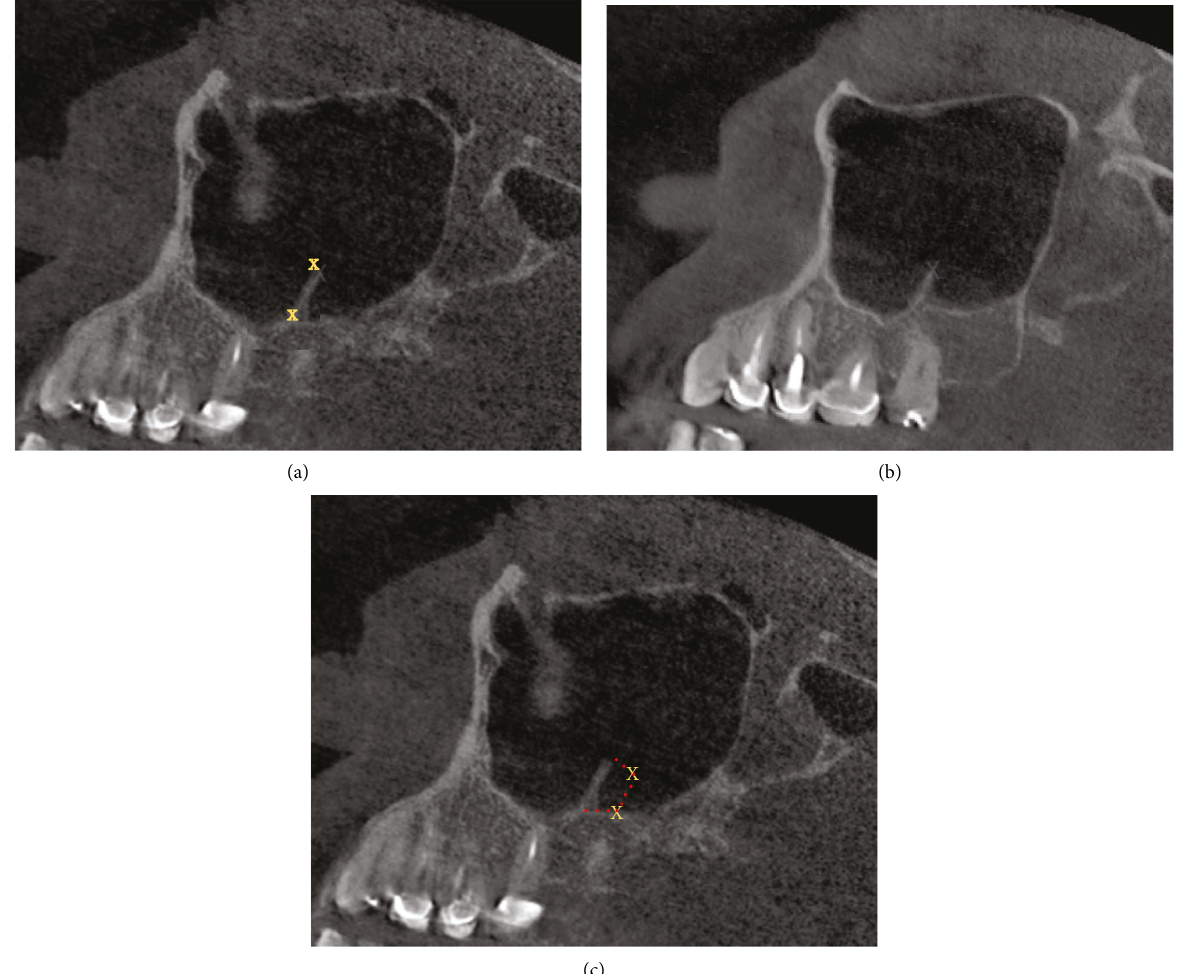
Figure 1: CBCT cuts showing the four points used in the calculation. Two medial points (blue) and two lateral points (blue).